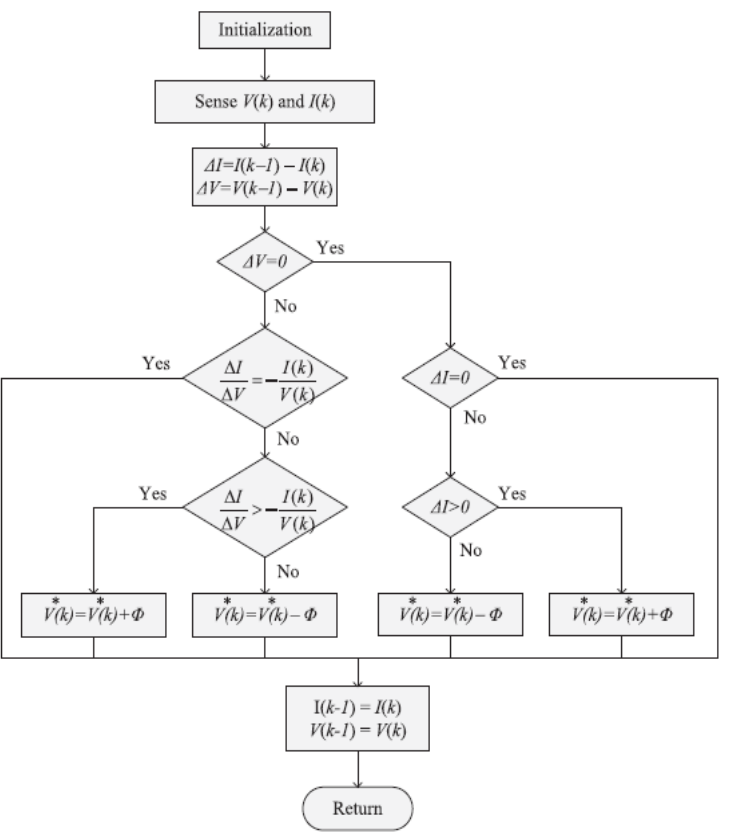
Figure 5. PV curve for the basic incremental conductance of MPPT.